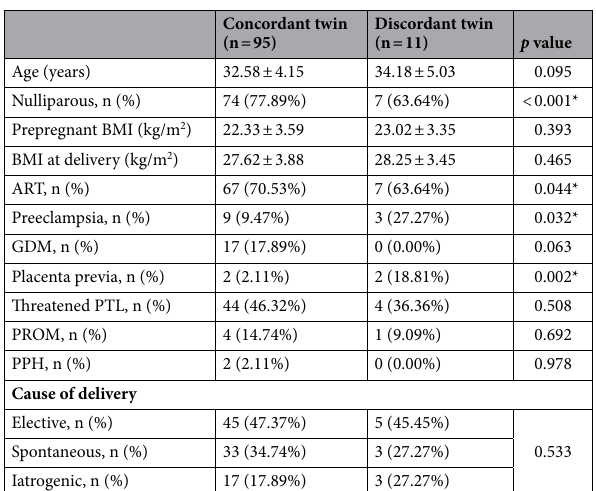
Table 1. Comparison of maternal characteristics and pregnancy-related complications between concordant and discordant twins at 20–24 weeks of gestation in DCDA twins. DCDA, dichorionic diamniotic; BMI, body mass index; ART, artificial reproductive technique; GDM, gestational diabetes mellitus; PTL, preterm labor; PROM, premature rupture of the amniotic membrane; PPH, postpartum hemorrhage. * p values of < 0.05 are shown in bold with an asterisk